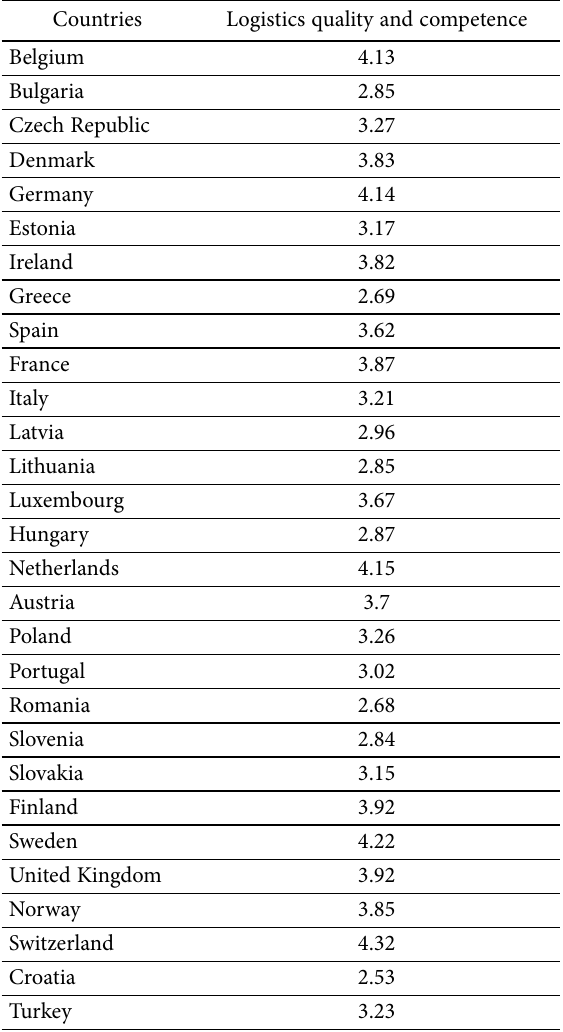
Table 2. Logistics quality and competence ranking scores of the selected countries in the international LPI survey (1 – lowest score, 5 – maximum score) (Arvis et al.